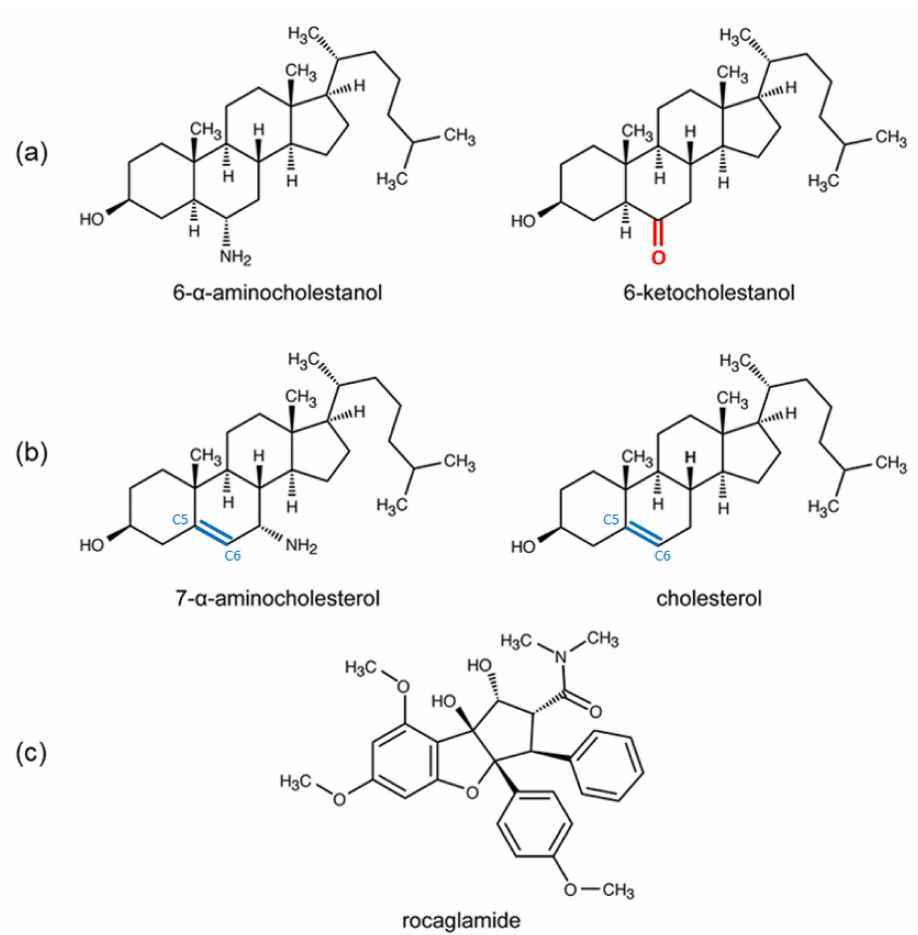
Figure 1. Chemical structures of the compounds used in this study. Chemical structures tested on the LieIF4A ATPase activity ( a ) cholestanol derivatives (6- α -aminocholestanol and 6-ketocholestanol), ( b ) cholesterol derivatives (7- α -aminocholesterol and cholesterol), ( c ) and rocaglate derivative (rocaglamide). The 6-ketocholestanol presents a keto group at position 6 ( in red ). The sterols present double bond between carbons 5 and 6 ( in blue